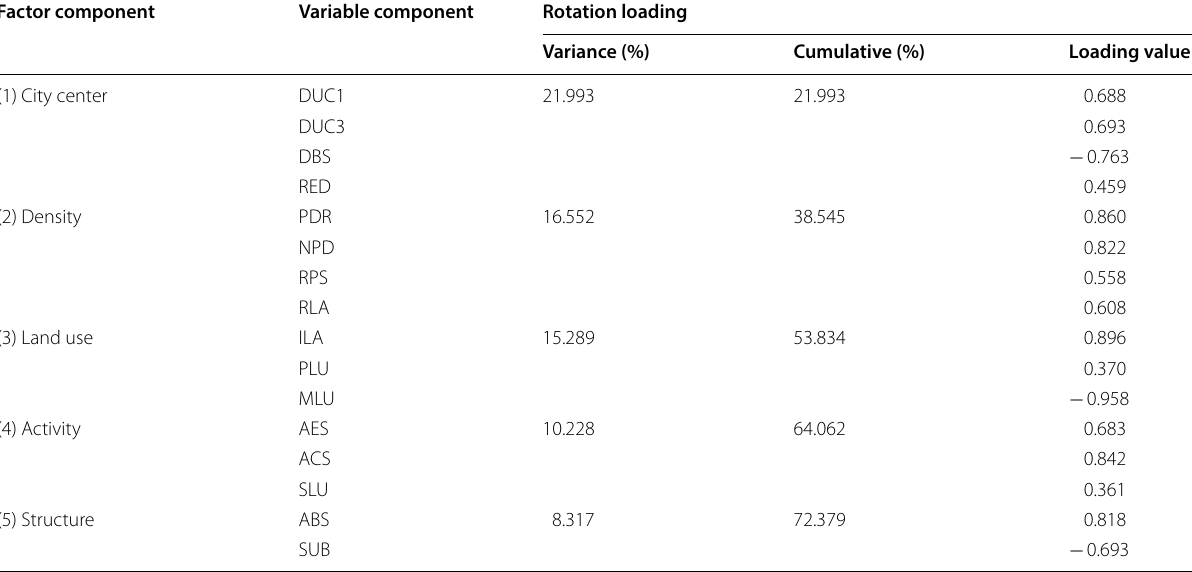
Table 2 Distributed loading values for factor components and their explained variance Factor